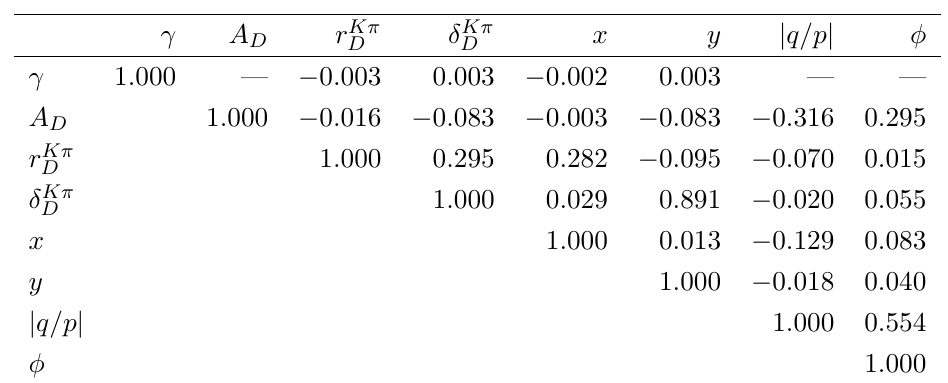
Table 6 . Reduced correlation matrix for the parameters of greater interest. Values smaller than 0 . 001 are replaced with a — symbol.